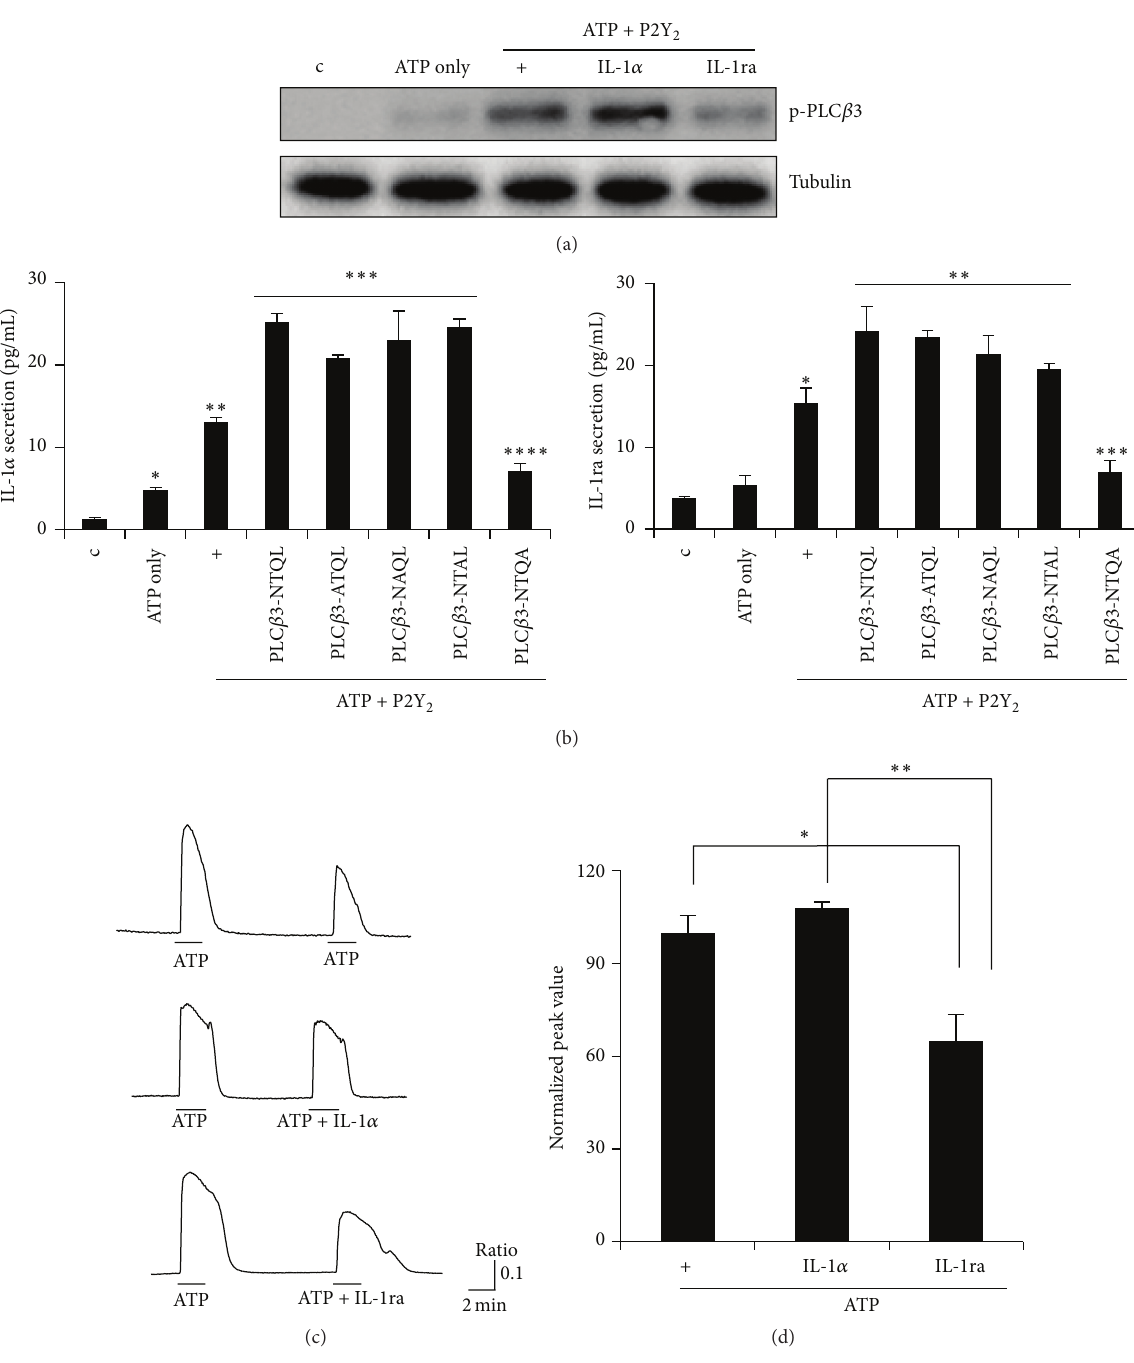
Figure 3: Effect of PLC 𝛽 3 activation on IL-1ra and IL-1 𝛼 secretion. (a) After transfection with wild-type P2Y 2 , the cells were subsequently treated with IL-1ra or IL-1 𝛼 for 4 hours prior to treatment with ATP for 5 min. PLC 𝛽 3 activation was measured by Western blot. Tubulin was used as a loading control. (b) Cells were transiently transfected with both wild-type P2Y 2 and wild-type ( 1231 NTQL 1234 ), dominant-negative PLC 𝛽 3 ATQL (N1231A), NAQL (T1232A), NTAL (Q1233A), or NTQA (L1234A) construct. Each of the individual residues of the PDZ-binding motif (NTQL) of PLC 𝛽 3 was mutated to Ala, respectively. Cells were serum-starved overnight and then treated with ATP for 4 hours, after which supernatants were harvested for ELISA. For IL-1 𝛼 ELISA (left panel), ∗ 𝑝 < 0.05 compared to the control, ∗∗ 𝑝 < 0.05 compared to ATP only, ∗∗∗ 𝑝 < 0.05 compared to ATP/P2Y 2 -treated cells, and ∗∗∗∗ 𝑝 < 0.05 compared to ATP/P2Y 2 /wild-type PLC 𝛽 3-treated cells. For IL-1ra ELISA (right panel), ∗ 𝑝 < 0.05 compared to ATP only, ∗∗ 𝑝 < 0.05 compared to ATP/P2Y 2 -treated cells, and ∗∗∗ 𝑝 < 0.05 compared to ATP/P2Y 2 /wild-type PLC 𝛽 3-treated cells. Data shown are representative of three independent experiments. (c) After transfection with wild-type P2Y 2 , the cells were treated with ATP, IL-1 𝛼 , or IL-1ra. Ca 2+ release was measured by adding increasing concentrations of Fura-2. See in Section 2. (d) Normalized peak value of the results in Figure 4(a). ∗ 𝑝 < 0.05 compared to ATP-treated cells, ∗∗ 𝑝 < 0.05 compared to ATP/P2Y 2 /IL-1 𝛼 -treated